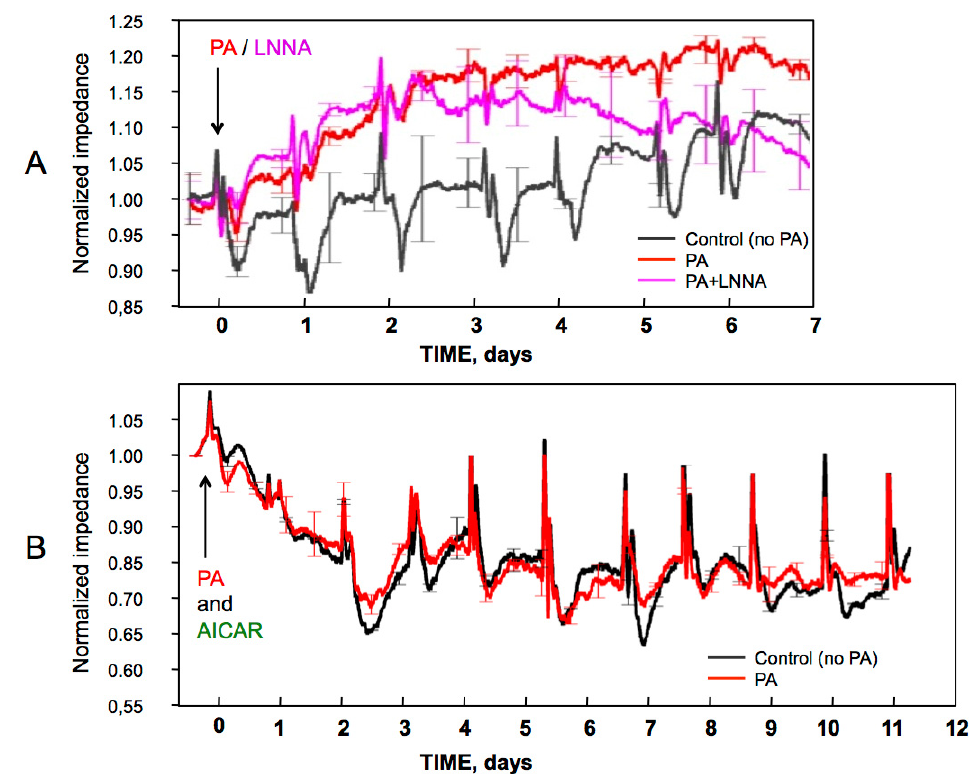
Figure 2. Effects of palmitate and/or AICAR/carnitine on transendothelial resistance (TER) of HUVEC monolayers. ( A ) PA increased TER of HUVEC monolayers in eNOS-dependent manner in the absence of AICAR. ( B ) AICAR negated the stimulatory effect of PA and moderately decreased TER, but the barrier was stably maintained at ~12 kOhm. PA, LNNA, or AICAR were applied at zero time as indicated by arrows. Cell media contained 40 μ M carnitine and were exchanged daily. Representative results of three independent assays are shown; bars indicate variability of triplicates.